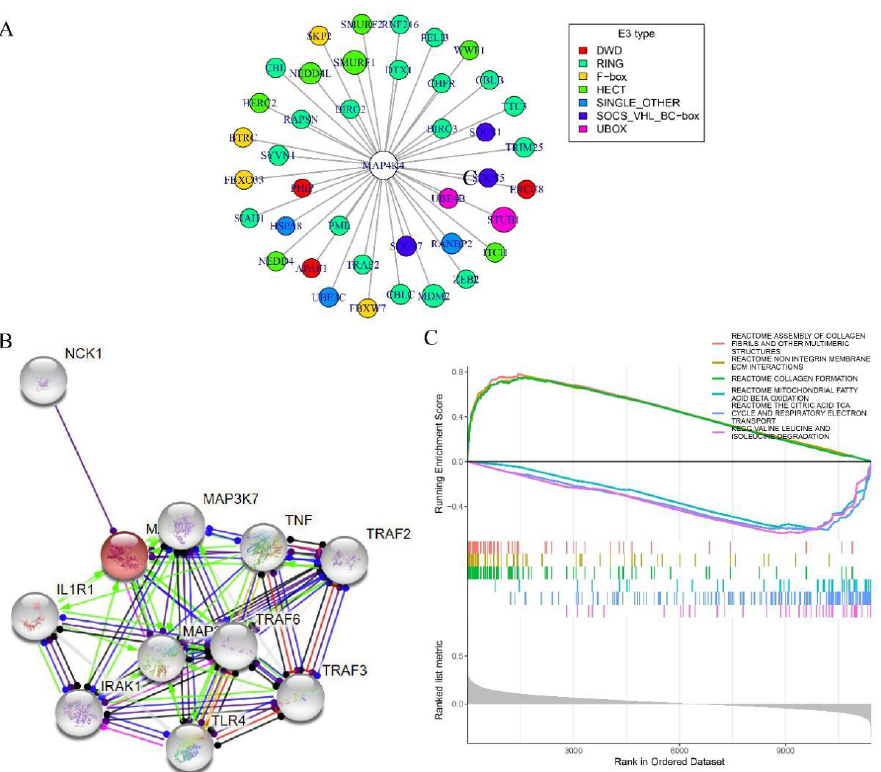
Figure 4. Protein and GSEA analyses of MAP4K4. ( A ) MAP4K4 protein-ubiquitination-prediction- relationship network; ( B ) MAP4K4 protein-interaction-relationship network; ( C ) GSEA analysis results of high- and low-MAP4K4-expression groups. Their statistical analysis is performed using the Cox risk regression model and chi-squared test.